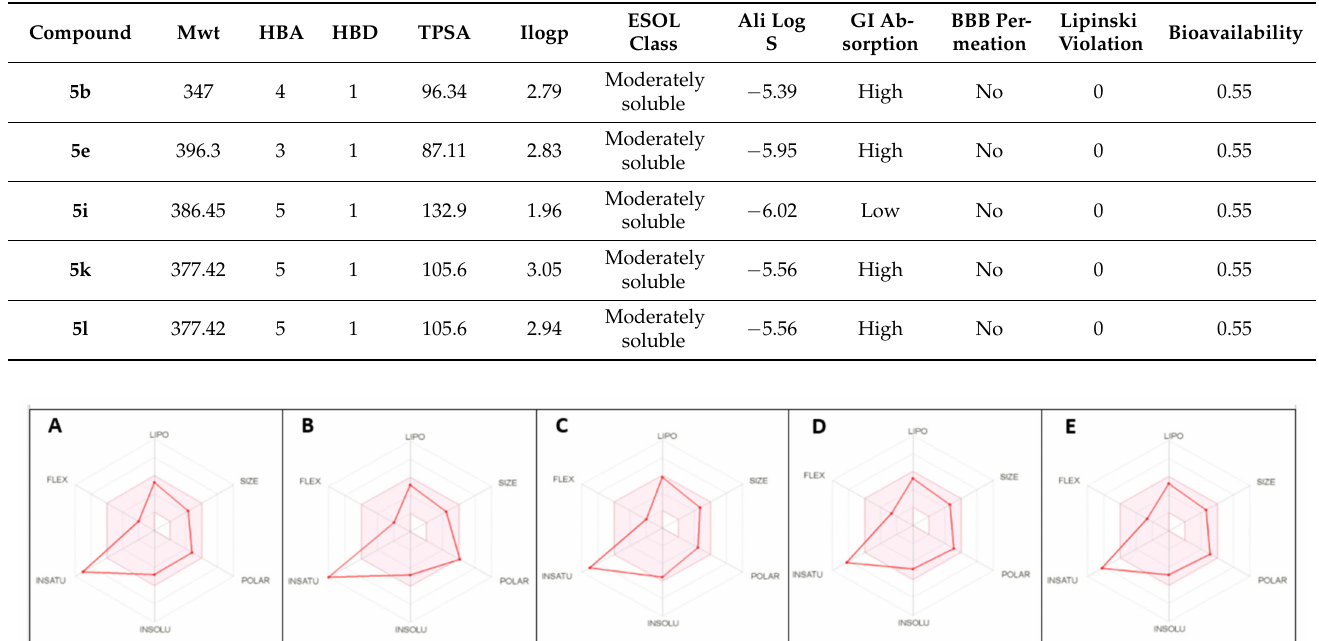
Table 3. Pharmacokinetic properties of the most active compounds as Bcl-2 inhibitor anticancer agents.